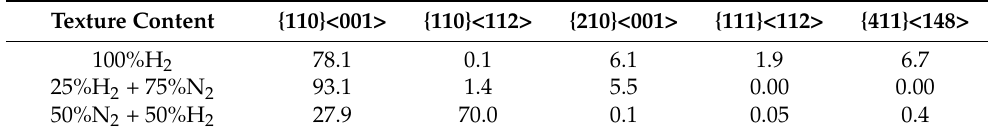
Table 2. Content of main texture